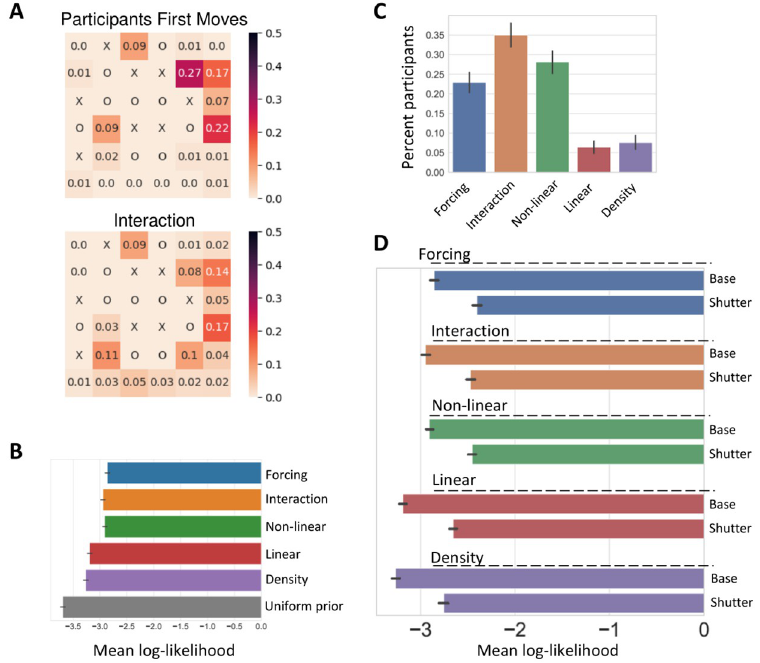
Fig 3. Participants’ moves indicate the use of scoring strategies. A) The distributions of first moves predicted by the “Interaction” scoring strategy and the distributions of participants’ actual first moves on this board. B) Log-likelihoods of scoring strategies’ predictions of participants’ moves. C) Percent of participants fitted to each scoring strategy. D) Log-likelihoods of scoring strategies’ predictions of participants’ moves. There are two configurations for each scoring strategy: using the scoring strategy as is (“base”) and adding the best fitted shutter value per each participant (see Methods). For all scoring strategies, adding the shutter significantly improved the log-likelihood and AIC scores (in all cases p < 10 − 5 using a likelihood ratio test). All error bars are 95% confidence